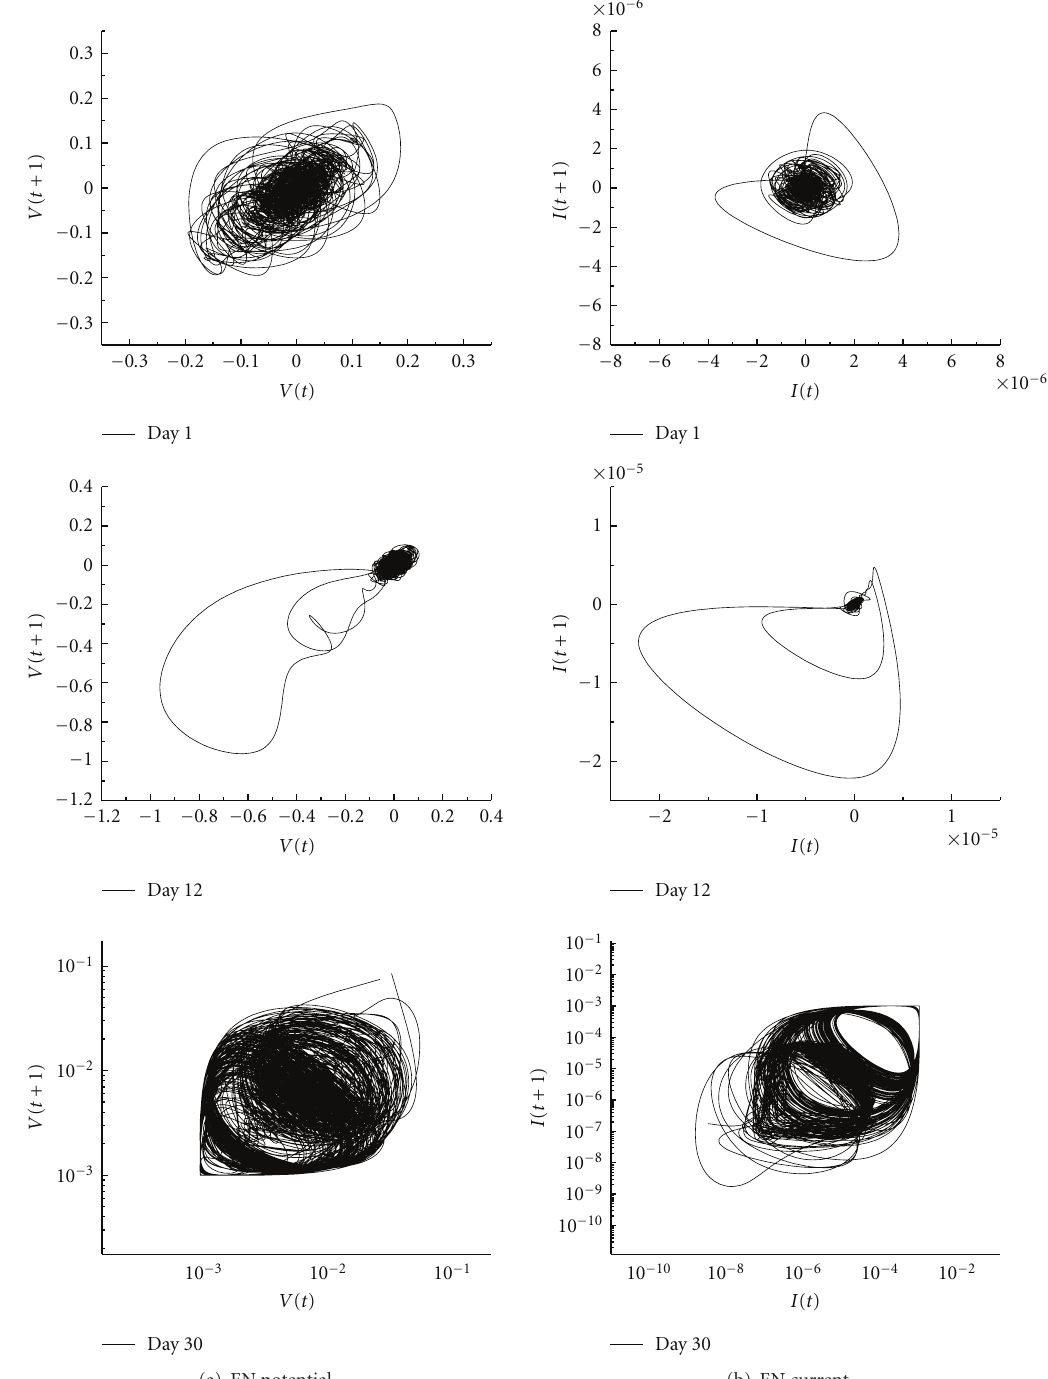
Figure 5: EN attractors for di ff erent times of